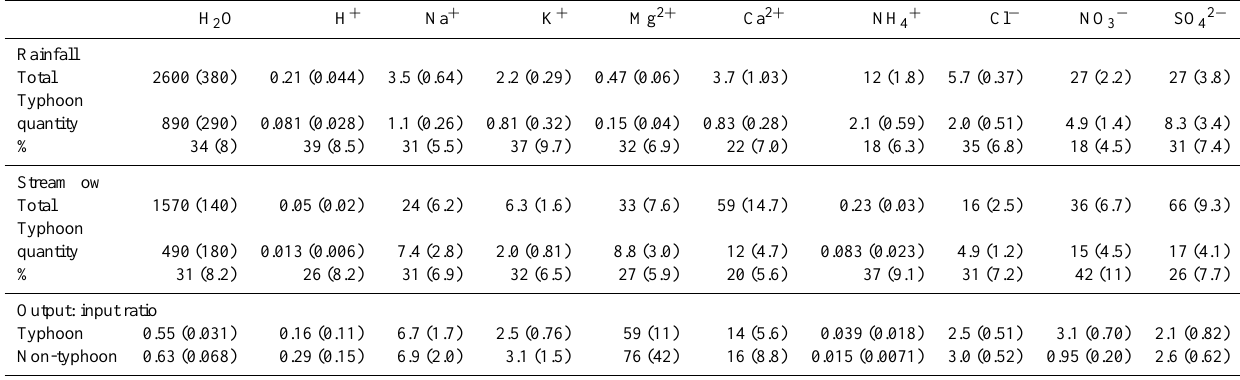
Table 2. Mean annual water (mm) and nutrient (kgha − 1 ) input through rainfall and output through streamwater at Lienhuachi Experimental Forest in central Taiwan between 2005 and 2010. Numbers in parenthesis are standard